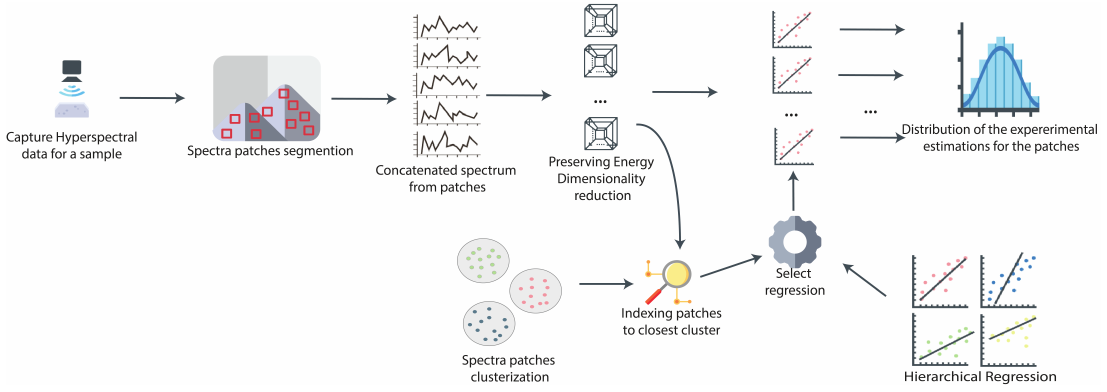
Figure 5. Prediction pipeline for a new